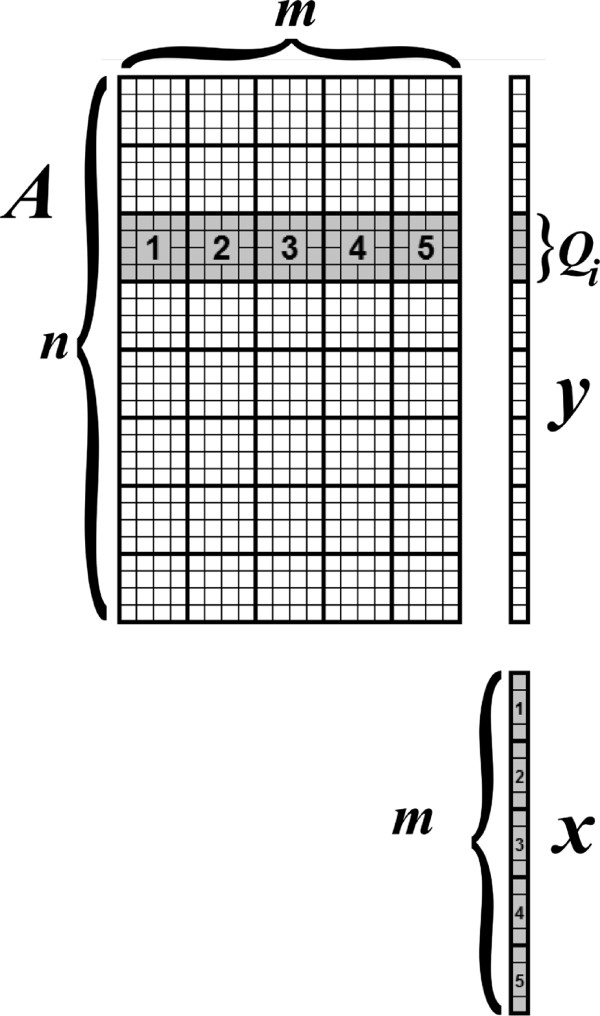
The computation of a q-length segment in a multiplication of a D-discrete matrix with a D-discrete vector.